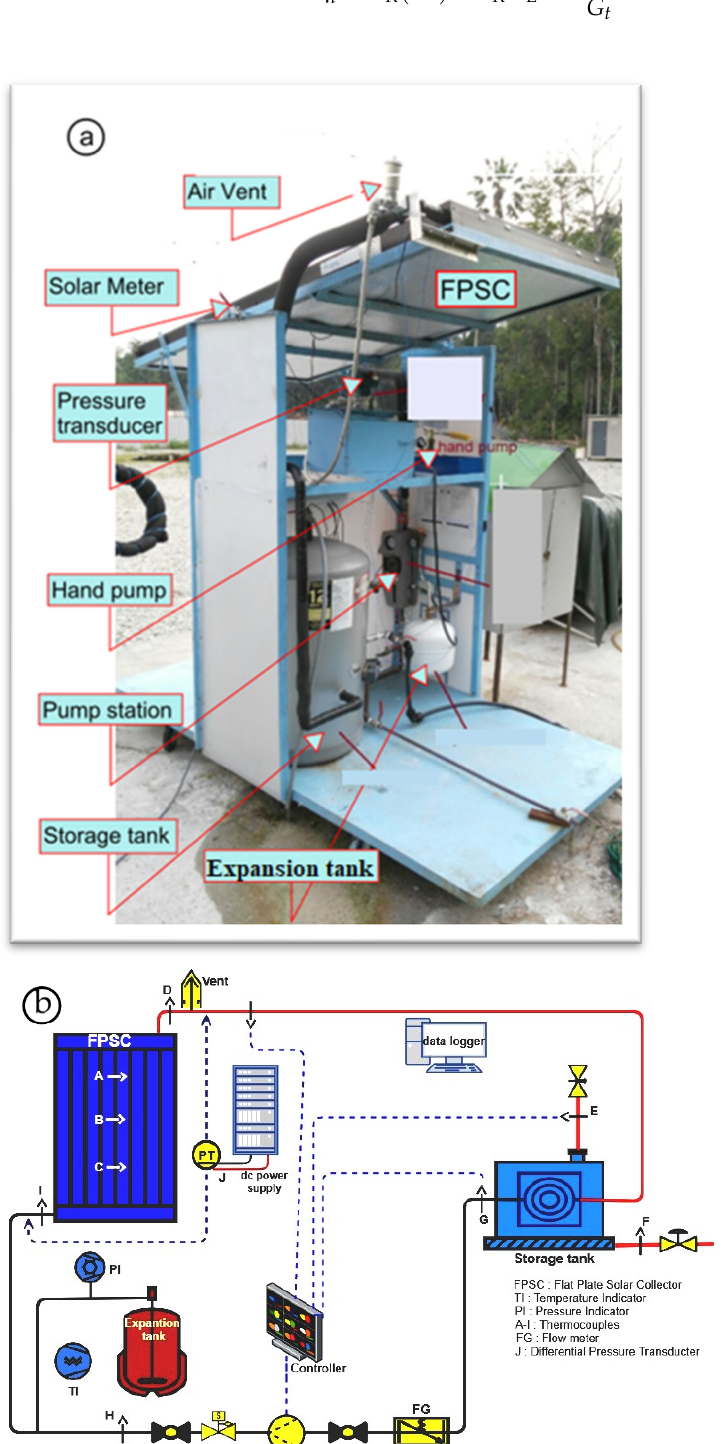
Figure 2. Schematic of the experimental setup: ( a ) rear view; ( b ) diagram of the experimental test. Table 2. Specifications of the flat plate solar collector system.